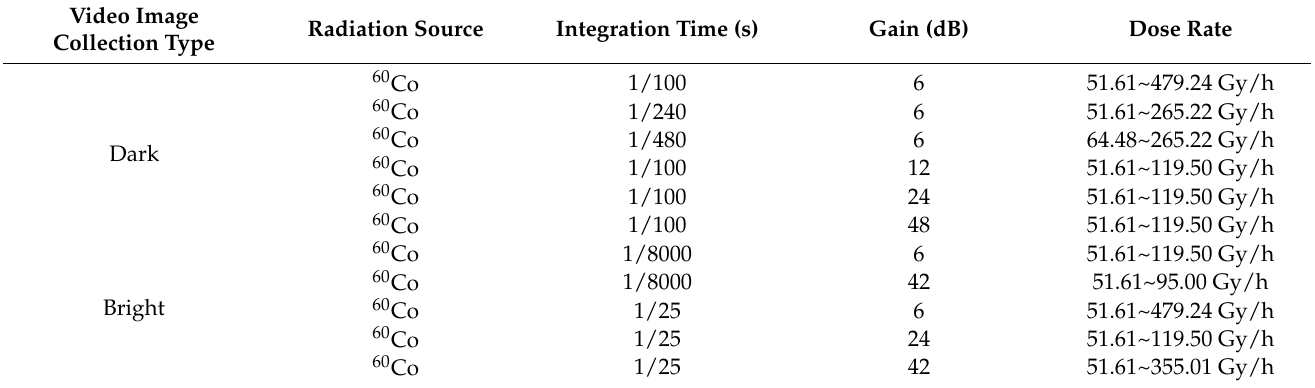
Table 1. Radiation experiment scheme of irradiation chamber.